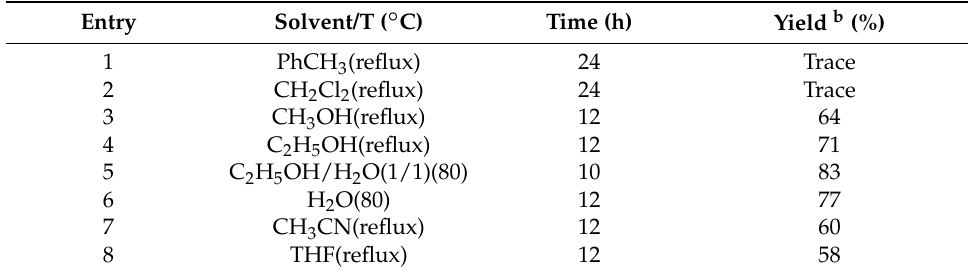
Table 1. Solvent effects on the reaction of isatin and dimedone, in the presence of 10 mol % magnesium perchlorate a .